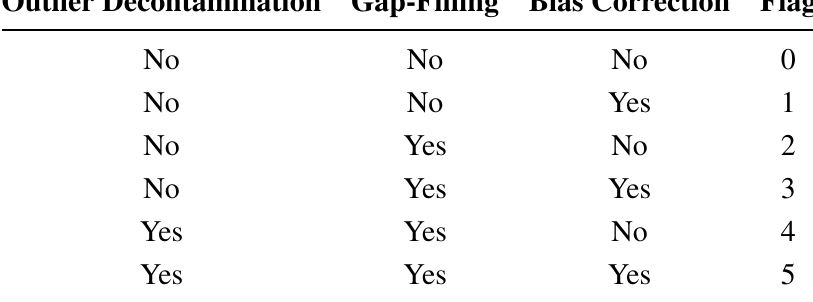
Table 1. Meaning of flag for the harmonized FAPAR product. Outlier Decontamination Gap-Filling Bias Correction